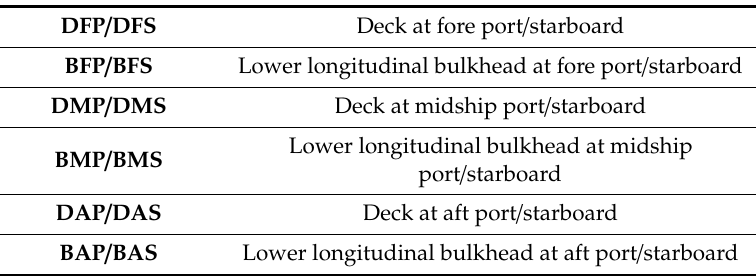
Figure 1. Stress measurement points (orange and blue circles are measurement points). ( a ) Top view and side view, ( b ) sectional view of the starboard side at the midship. Table 2. Location details of each strain sensor.